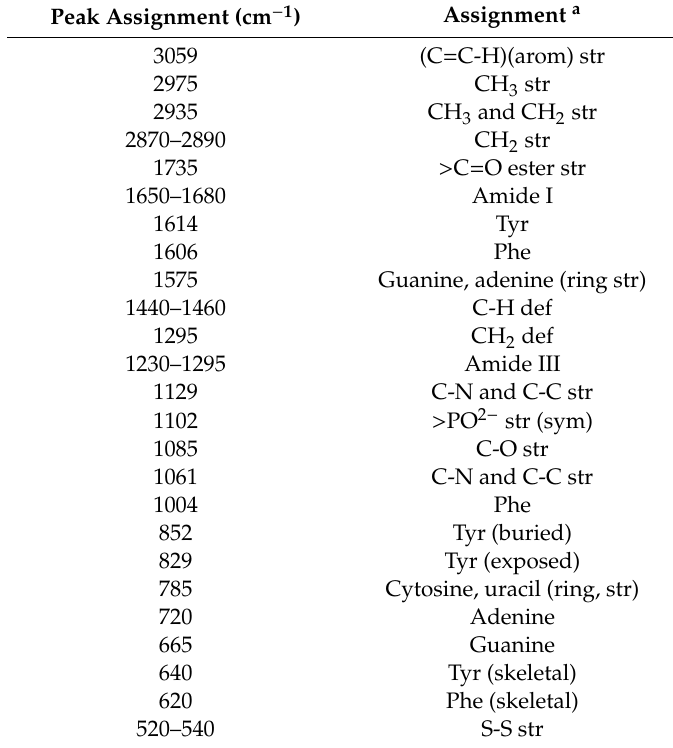
Table 1. Tentative assignments of important bands in FTIR and Raman spectra in cells of biological specimens [38].